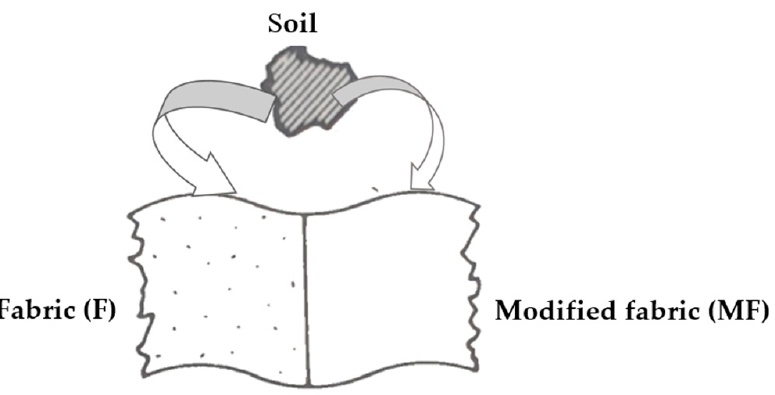
Figure 12. Schematic view of soil deposition on fabric and fabric modified with CMC/CMS. The degree of inhibition of stain transfer, or re-deposition, is associated with certain types of stain donors (Table 2) that are classified into different groups: (1) pigment and oil (E-101 and E-104), (2) tannin (E-114), and (3) protein (E-116). The applied stain donors pigment in oil on the cotton and polyester/cotton textile carrier are more relevant in relation to tannins and proteins as donors. The power of removing the pigment in the oil represents the general washing effect and requires the synergy of all the factors of the Sinner’s circle. Tannins are removed by the physicochemical action of bleaches and their activators, where the washing temperature with the listed ingredients represents a significant factor. Protein stains are removed by the action of proteolytic enzymes, which is better achieved at lower temperatures